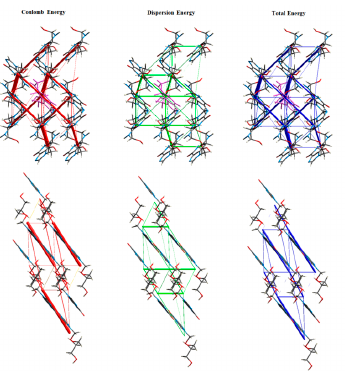
Figure 10. Energy framework diagrams, using the CE-B3LYP model, a scale tube size of 20 and cut-off value of 0 kJ/mol. The top row represents form I (viewed down the c axis), and the bottom row is associated with form II (viewed down the b axis). Molecules are clustered around the cen- tral molecule (pink) with a 3.8 Å radius. In form II, N1–H ⸱⸱⸱ O1 and N2–H ⸱⸱⸱ N3 are the strongest interactions both of which contribute towards the dominant electrostatic energy ( − 73.6 kJ/mol) along the planes of aromatic rings. A secondary energy contribution ( − 45.2 kJ/mol) in the same direction is attributable to the N1–H ⸱⸱⸱ O4 contact. The out-of-plane interactions are mainly a result of dispersion contacts and the O4–H ⸱⸱⸱ O1 electrostatic interaction. However, such a contri- bution is considerably low ( − 18.3 kJ/mol) relative to the other energy components along the aromatic systems plane.